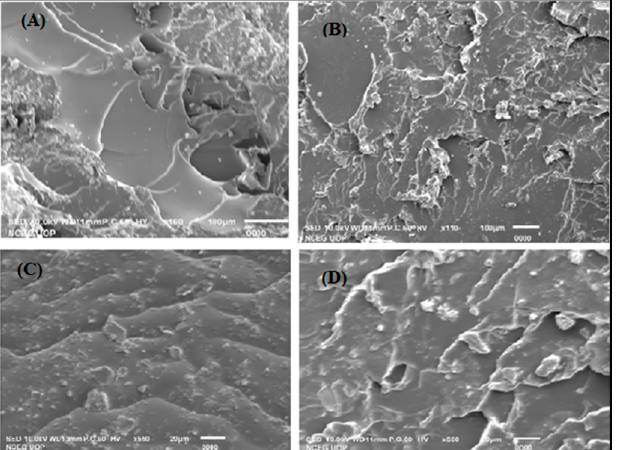
Figure 9. SEM microstructures of surface morphology of unloaded and loaded hydrogels ( A and C ) and cross-sectional morphology of un-loaded and loaded hydrogels ( B and D